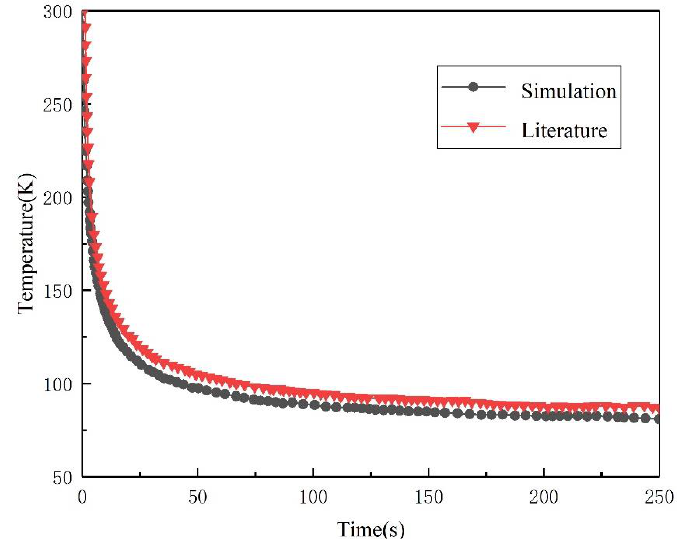
Figure 2. Comparison of simulation results with previously reported results.